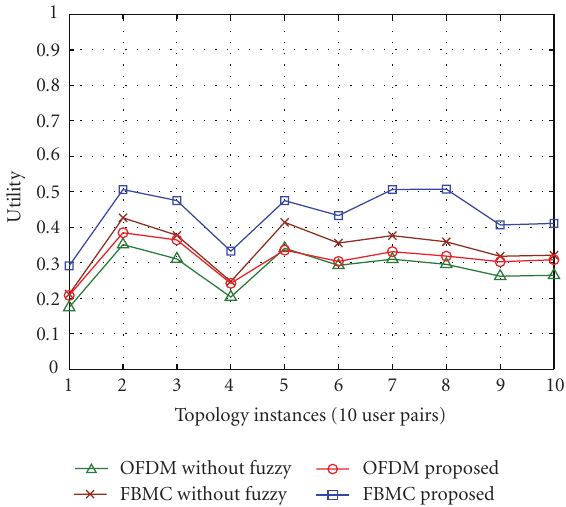
Figure 7: Utility function for the proposed algorithm with FBMC and OFDM.